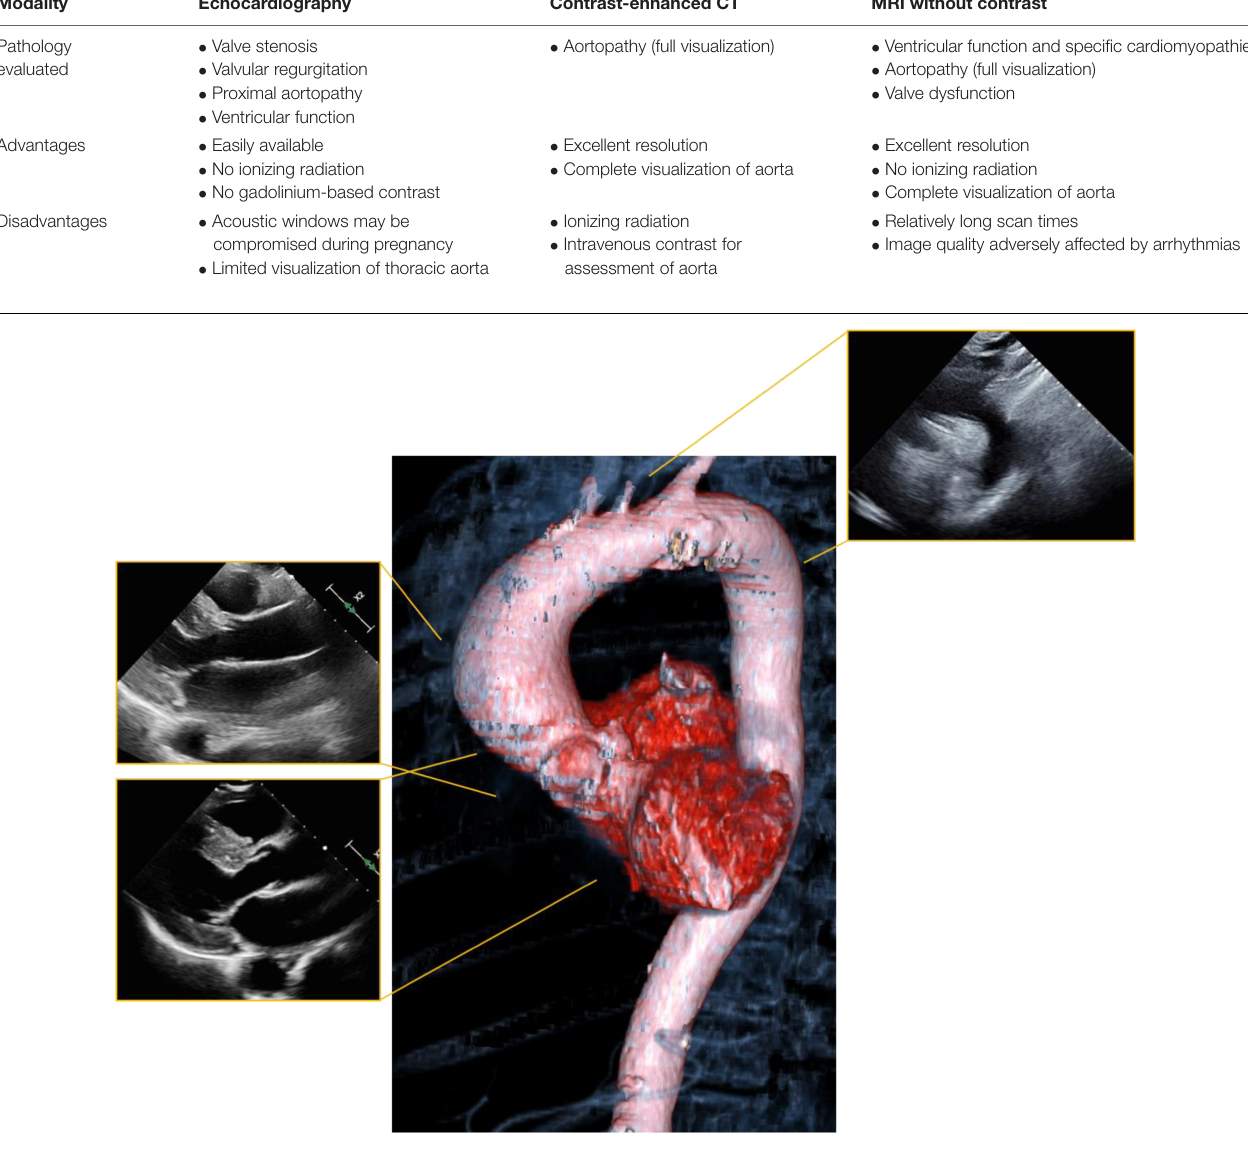
FIGURE 1 | Visualization of the aorta with echocardiography. Standard parasternal and suprasternal notch views (periphery) leave a significant portion of the aorta unvisualized. Computer tomography (CT) or magnetic resonance imaging (MRI) can visualize the aorta in three dimensions (center) and allows for comprehensive evaluation of